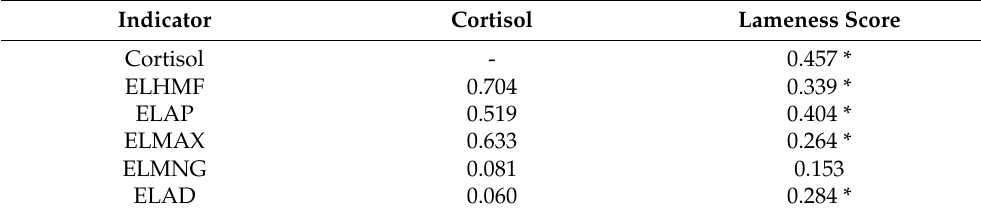
Table 3. Correlation of blood cortisol concentration and lameness score with electrical conductivity variables of milk flow in 64 cows with signs of lameness and 56 healthy cows (with an average of 2.8 lactations and 60 days of the postpartum period).